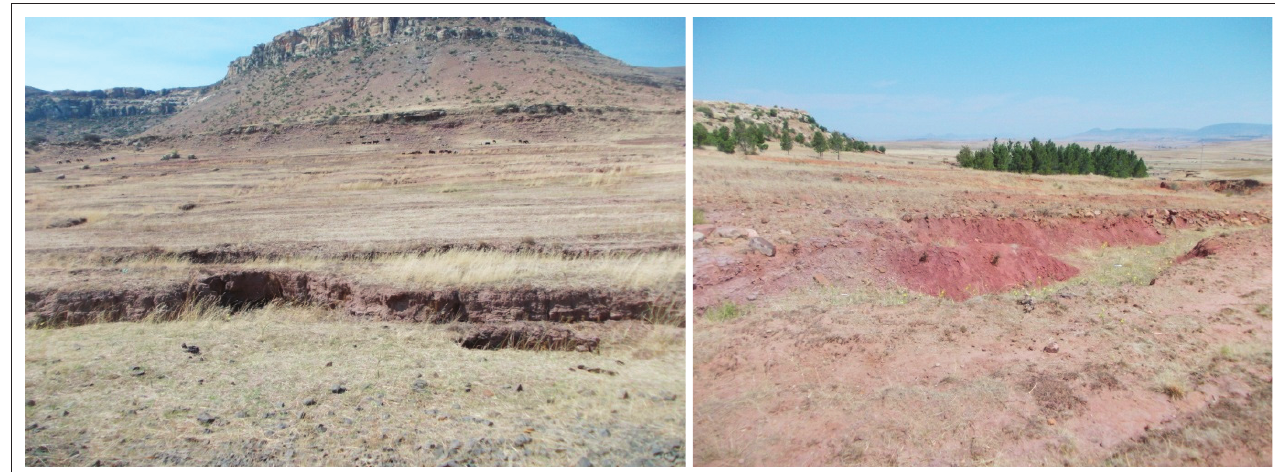
FIGURE 2: Eroded fields between Ha Ngoae, Khubetsana and